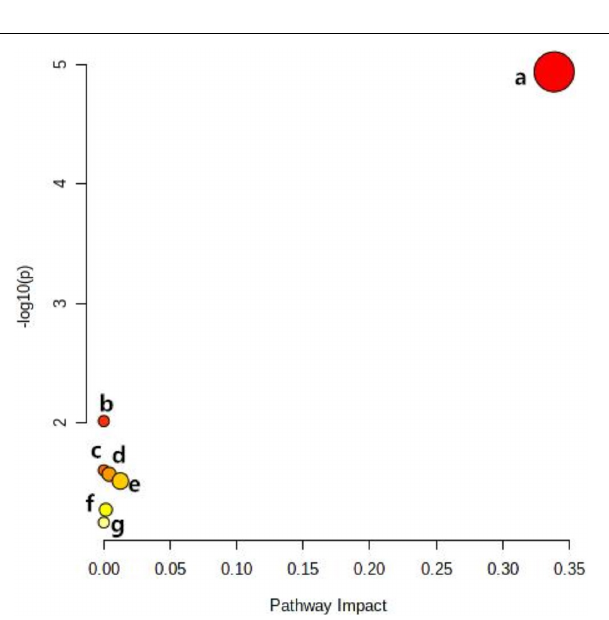
FIGURE 4 | ROC curves: purple: LG; red: the SVM; black: RF; yellow: GBM.